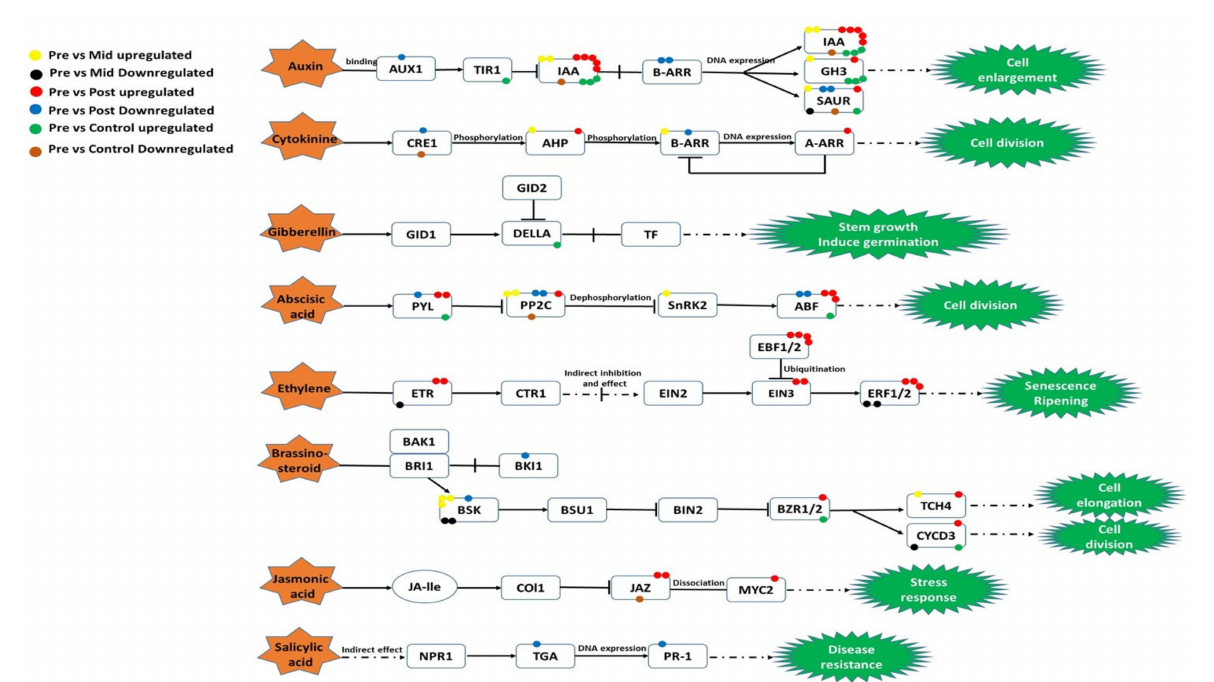
Figure 6. DEGs involved in plant hormone signal transduction pathways in the stem of water dropwort. Yellow color balls represent upregulated DEGs of ‘pre vs. mid-blanching’ and black color represents downregulated DEGs of ‘pre vs. mid-blanching’. Red color balls represent upregulated DEGs of ‘pre vs. post-blanching’, the blue color represents downregulated DEGs of ‘pre vs. post-blanching’, green color balls represent upregulated DEGs of ‘pre vs. control’ samples, and the brown color represents downregulated DEGs of ‘pre vs.